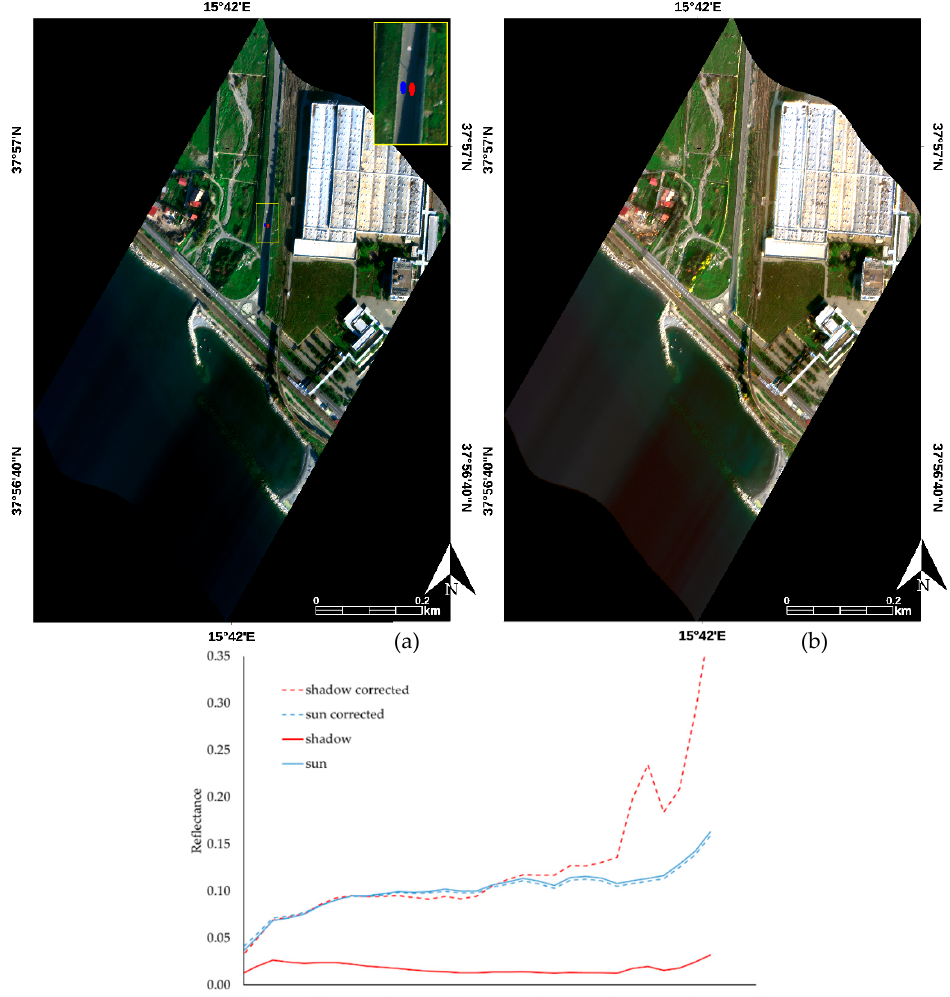
Figure 14. RGB (R: 653 nm, G: 546 nm, B: 439 nm) images before ( a ) and after ( b ) the application of topographic correction related to a subsets of the Reggio Calabria CASI image, corresponding to an industrial context. The zoomed area in (a) highlights the ROIs relates to shadow (red) and exposed (blue) areas. On the graph the mean spectra of the two ROIs, before (solid lines) and after (dashed lines) the application of topographic corrections are shown.